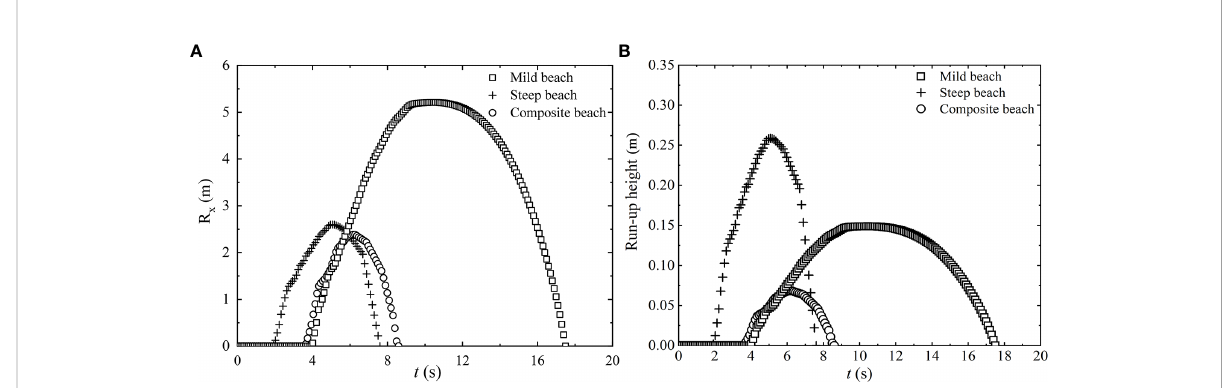
FIGURE 5 Time series of the shoreline location ( R x ) (A) and runup height (B) based on the camera video recording.